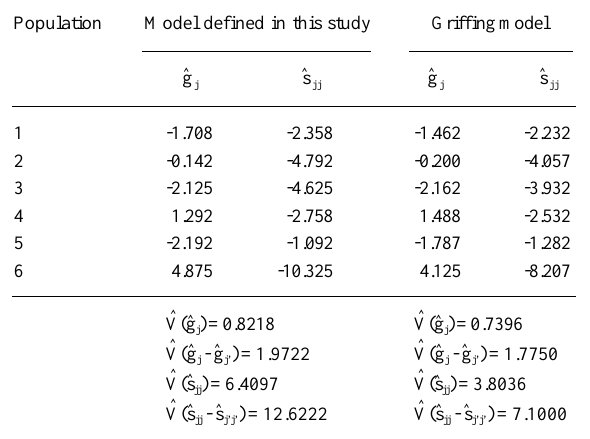
Table III - Estimates of the GCA effects (g ), the SCA effects j of a population with itself (s ), the variances of these effects and jj of the variances of contrasts between themselves for the model defined in this study and for the Griffing (1956b) model.